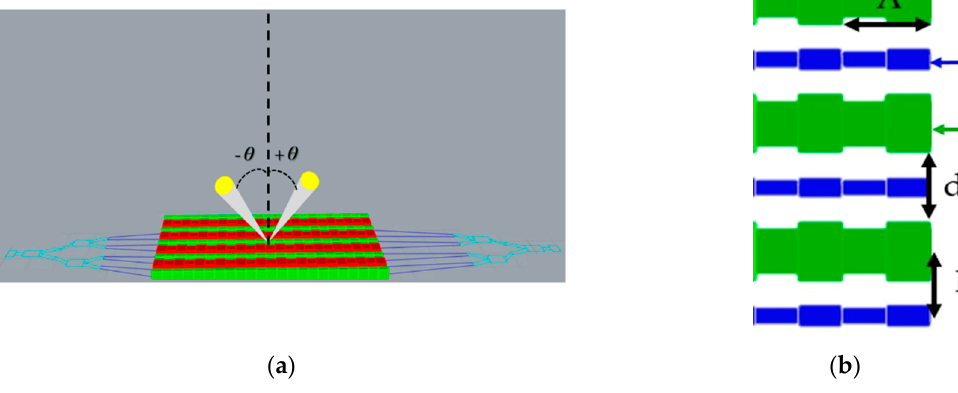
Figure 2. ( a ) Dual-beam schematic diagram for a bi-directional FBG dual grating antenna array and the zero-degree top light steering to ± θ angles, respectively, for emitting. ( b ) The schematic is demonstrated by adding SR-based